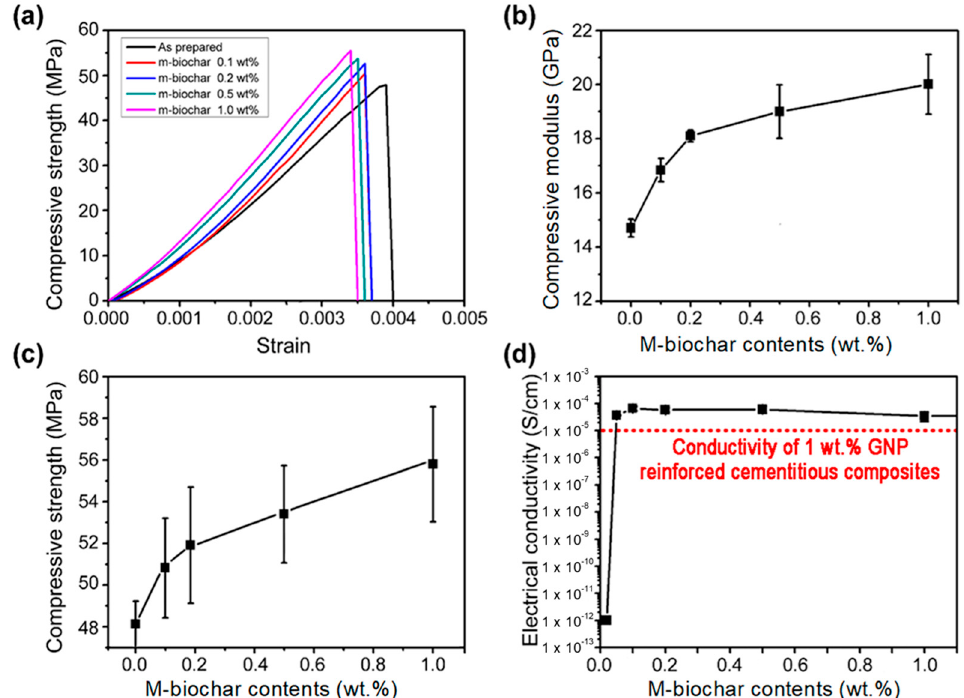
Figure 4. Mechanical and electrical characterization of m-biochar-reinforced cementitious composites with different weight loadings of m-biochar: ( a ) representative compressive stress–strain curves; ( b ) average compressive modulus; ( c ) average compressive strength; and ( d ) electrical conductivity (red line: 1 wt.% GNP reinforced cementitious composites).